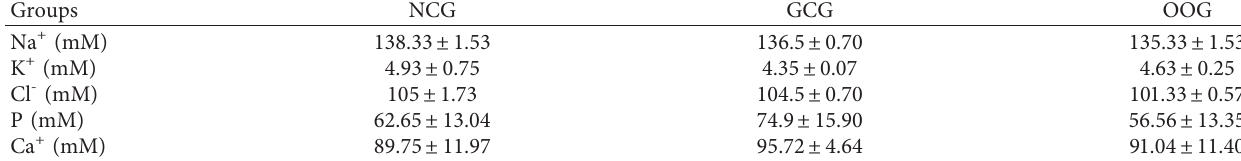
Table 3: Effect of ODSO on plasma electrolyte levels in rats with or without gentamicin administration. Groups